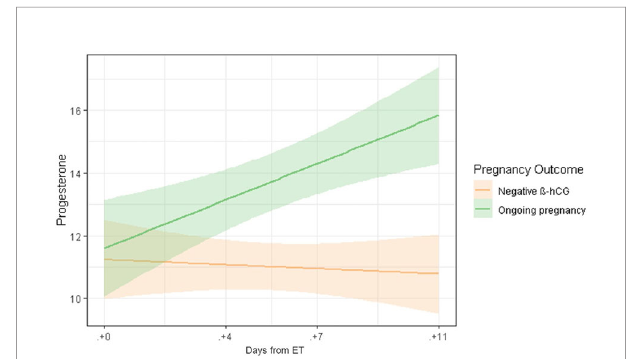
FIGURE 3 | Linear regression model of serum P levels throughout the late luteal phase, comparing ongoing pregnancies (green) and negative b -hCG cases (orange).